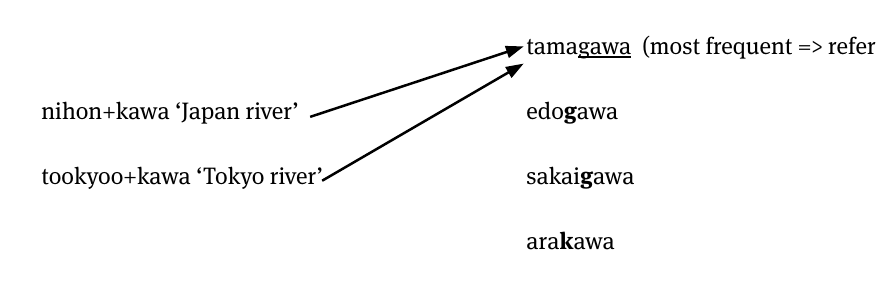
Figure 1 . Analogy-based model with lexical